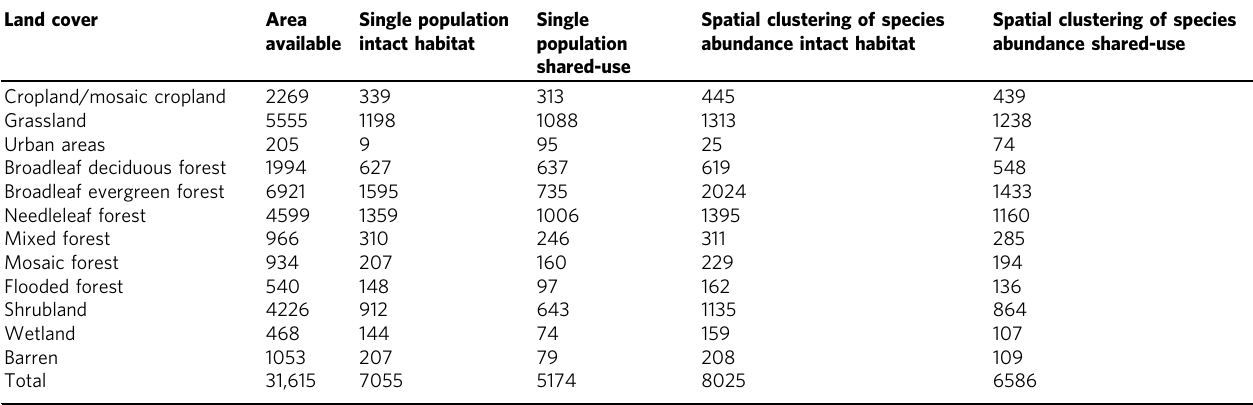
Spatial clustering of species abundance shared-use